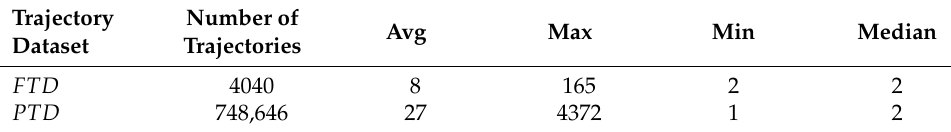
Table 4. Statistical properties of the lengths in trajectory data sets. Trajectory